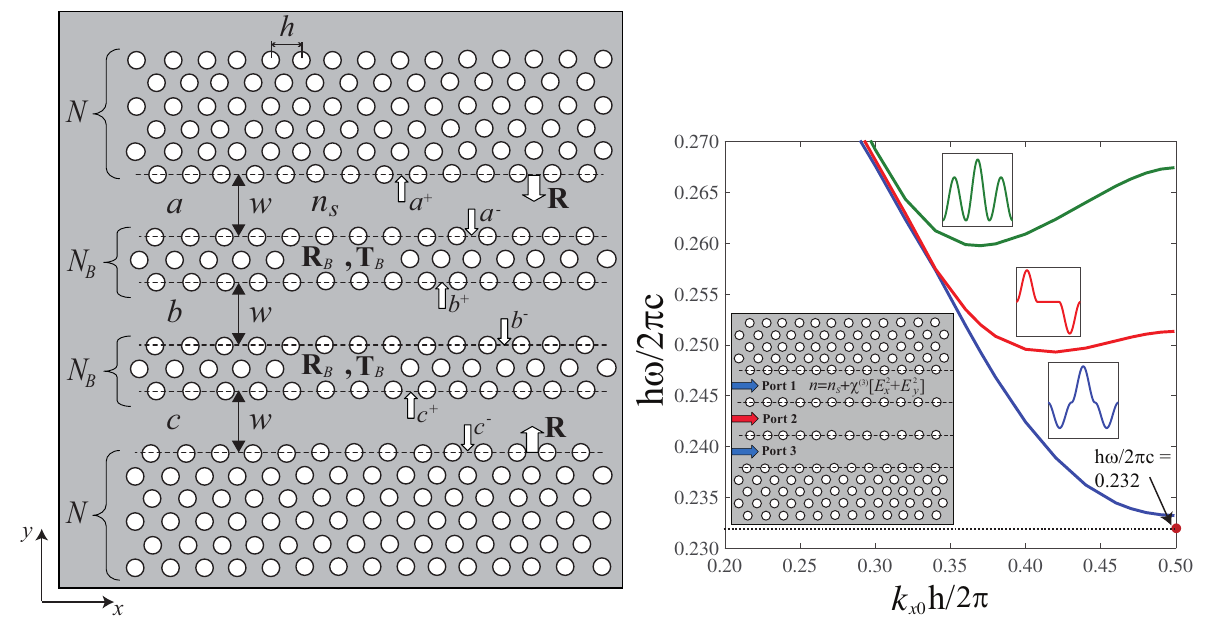
Figure 1. ( Left ) Three PhC waveguides with guiding regions ( a ) , ( b ) and ( c ) having the same widths w . The waveguides are separated by the barrier layers with number of layers N B . Planar PhCs are composed of a hexagonal lattice of the circular air holes periodically spaced along the x -axis with a period of h , which are infinitely long along the z -axis. n s is the refractive index of the background medium and radius of the air holes is r . Here, a + and a − , b + and b − , c + and c − define the up-going and down-going space-harmonics in the guiding regions ( a ) , ( b ) and ( c ) , respectively. ( Right ) Dispersion diagram of the even (blue and green curves) and the odd (red curve) modes for H -polarized field. The operating frequency = 0.232 (red dot). Insets show the distributions of the magnetic field H z for the modes, as well as the is chosen as h ω 2 π c geometry of the setup. Reprinted from Ref.